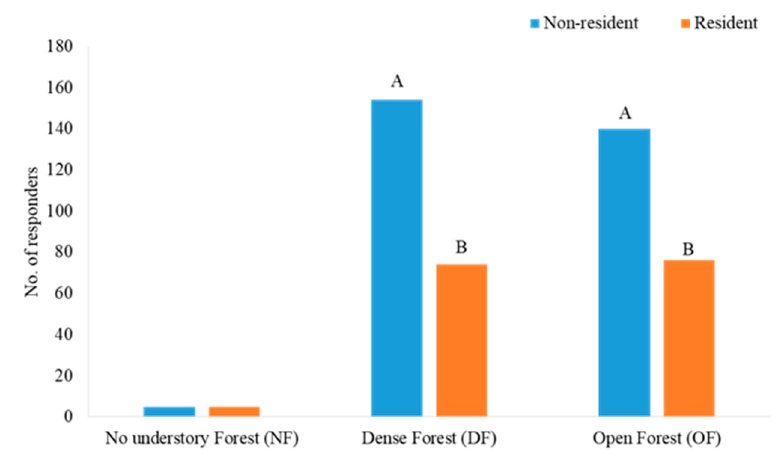
Figure 8. Number of individuals (pooled across responding species) responding to mobbing calls (pooled across caller species) in NF, DF, and OF forest habitats in the winter. Different capital letters above bars indicate significant differences between the number of responding all-year resident and wintering species in each forest type using binomial test ( p < 0.05).